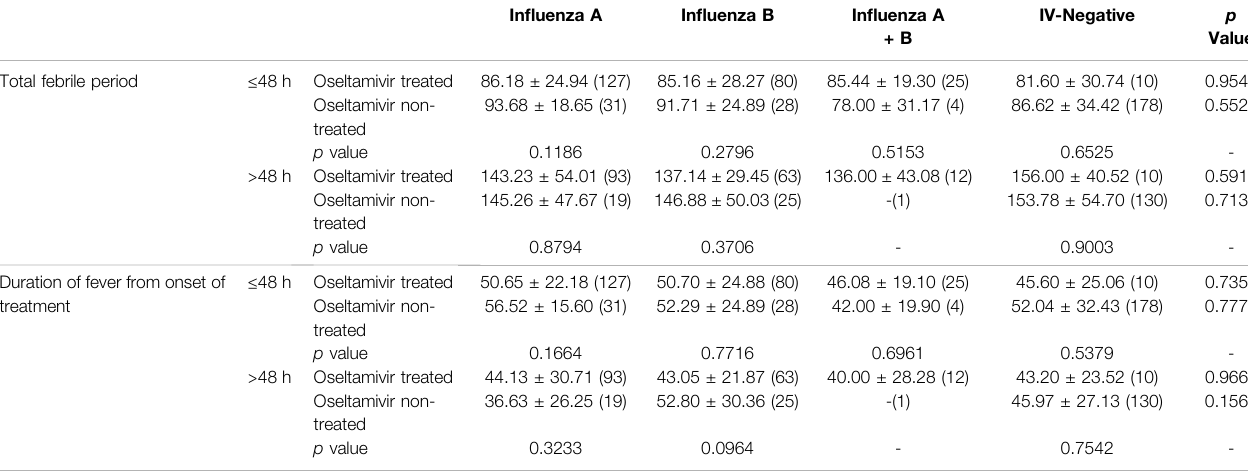
Data are Mean h ± SD (No. of patients).-: not applicable.